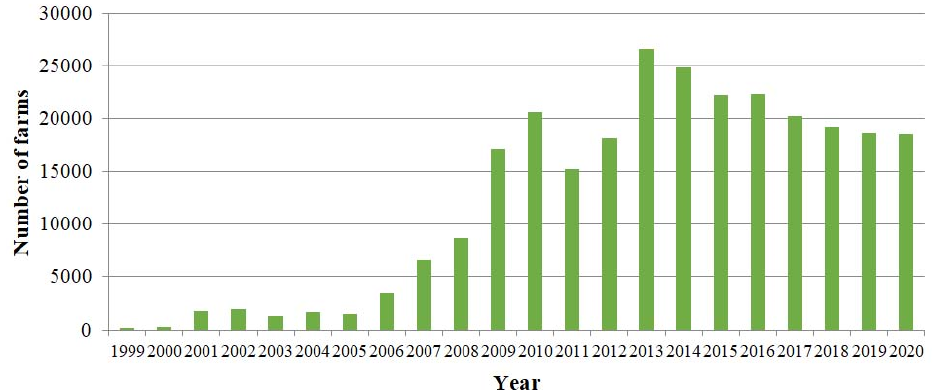
Figure 1. Number of organic farms in Poland in the years 1999–2020. Source: Own study based on the Inspection of Purchase and Processing of Agricultural Products [31] (p. 7); [32] (p. 9); [33] (p. 10); IJHARS [34] (p. 5); [35] (p. 7); [36] (pp. 11,12); [37] (pp. 13, 14); [38] (pp. 24, 38); [39] (pp. 26, 42); [40] (pp. 23, 36); [41] (p. 33); [42] (p. 32); [43] (p. 31).